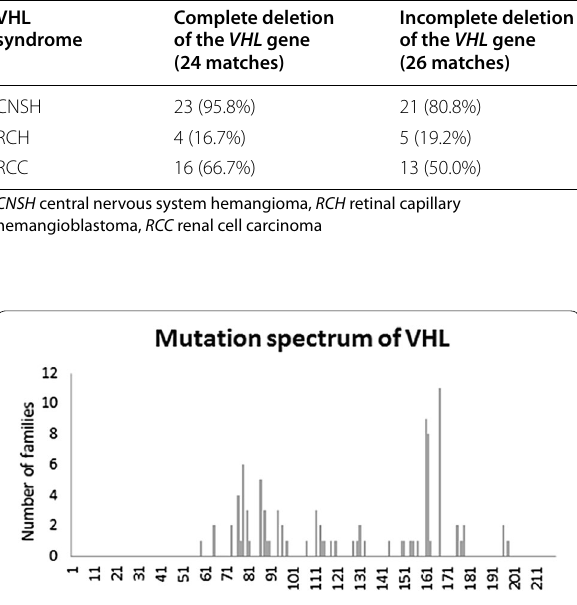
Table 3 Major complications of VHL syndrome and extent of deletion of the VHL gene